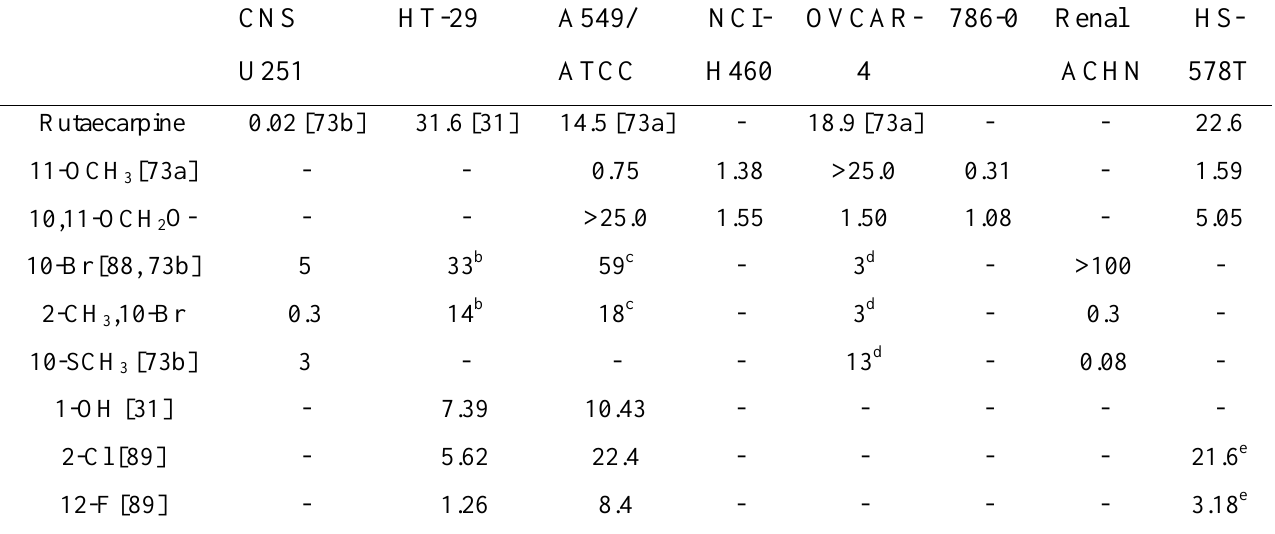
values in μ M) 50